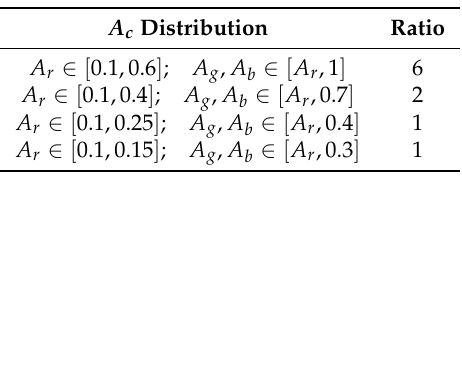
Table 1. Method to generate A c